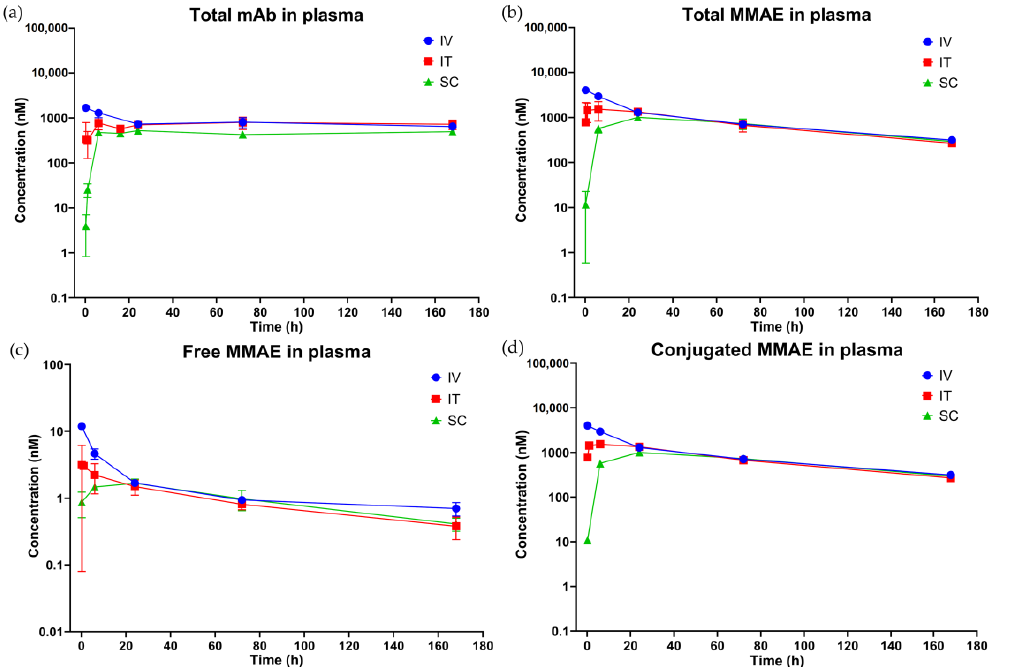
Figure 3. Observed plasma pharmacokinetics (PK) of ADC analytes in mice after intravenous (IV), intratumoral (IT), and subcutaneous (SC) administration of 10 mg/kg of T-vc-MMAE single dose. ( c ) unconjugated MMAE; and ( d ) conjugated MMAE in plasma.